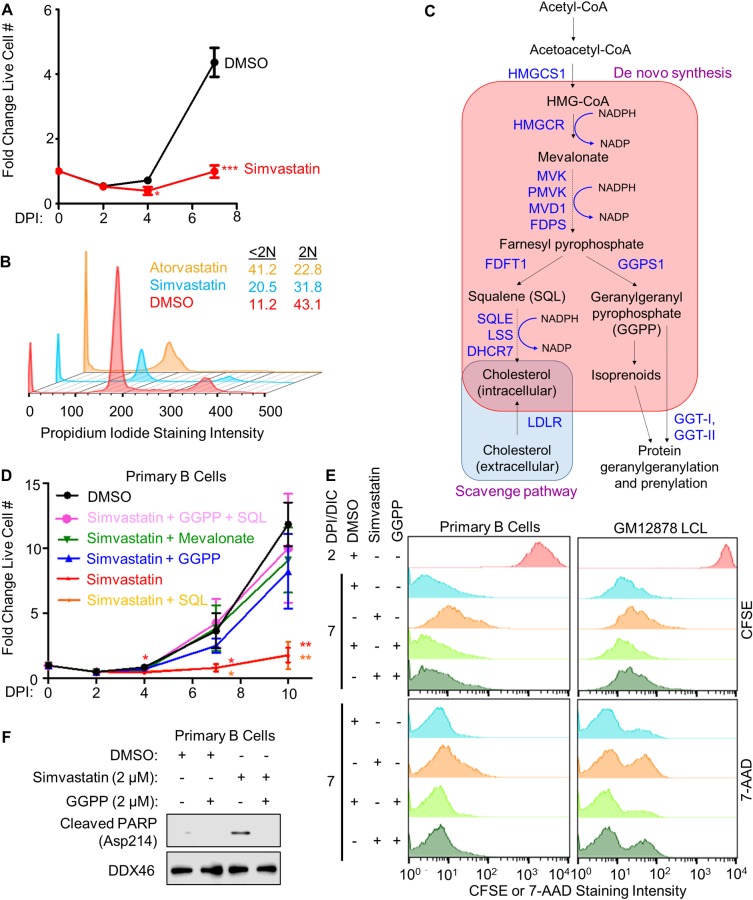
EBV-induced mevalonate metabolism supplies geranylgeranyl pyrophosphate (GGPP) for newly infected B-cell outgrowth.(A) Fold change in live cell number of primary human B-cells infected by EBV B95-8 for the indicated DPI, cultured in the presence of DMSO or simvastatin (2 μM) from 2–7 DPI. Simvastatin was refreshed at 4 DPI. Data show the mean + SEM from n = 3 replicates. *, p<0.05; ***, p<0.005 (two-tailed t-test). (B) Flow cytometric analysis of propidium iodide levels in fixed primary B-cells that had been treated with DMSO or the HMG-CoA reductase inhibitors simvastatin (2 μM) or atorvastatin (2 μM) from 2 DPI to 7 DPI. Representative cell cycle analysis plots from n = 2 experiments are shown. The percentages of cells with <2N (sub-G1) and 2N (G1) DNA content are indicated. (C) Schematic diagram of the mevalonate pathway branches that produce cholesterol or isoprenoids, with key enzymes indicated in dark blue color. Acetyl-CoA can be reduced in an NADPH-dependent manner by HMGCR to produce mevalonate. Mevalonate is then converted into farnesyl pyrophosphate, which can either be used to synthesize squalene for cholesterol biosynthesis or be diverted toward GGPP syntheses. Cholesterol can also be scavenged from the extracellular environment via the LDL receptor (LDLR). (D) Relative fold-change in live cell numbers of newly infected primary B-cells cultured in the presence of DMSO or simvastatin (2 μM) and supplemented with squalene (SQL, 100 μM), geranylgeranyl pyrophosphate GGPP (2 μM) or mevalonate (500 μM) as indicated from 2 to 7 DPI. Simvastatin, GGPP, SQL and mevalonate were refreshed at each timepoint. Data show the mean + SEM from n = 3 replicates. *, p<0.05; **, p<0.01 (two-tailed t-test). (E) Flow cytometric analysis of CFSE dye dilution proliferation and 7-AAD cell death assays in newly infected primary B-cells or GM12878 LCL. Cells were treated with DMSO, simvastatin (2 μM) and/or GGPP (2 μM), as indicated from days post-infection (DPI) 2–7, or from days in culture (DIC) 2–7 for GM12878 LCLs. Representative histograms from n = 3 replicates are shown. See also S4E Fig. (F) Immunoblot analysis of WCL from newly infected primary B-cells cultured in the presence of DMSO, simvastatin or GGPP from days 2–7 post infection. Cleaved PARP (aspartate 214 specific) was detected, together with DDX46 load-control. Representative blots from n = 3 experiments are shown.